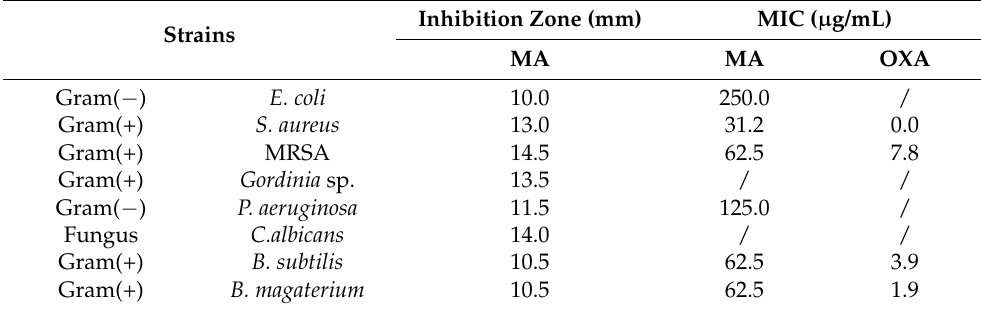
Table 1. Diameter of inhibition zone (mm) and MIC ( µ g/mL) of MA against E. coli , S. aureus ,